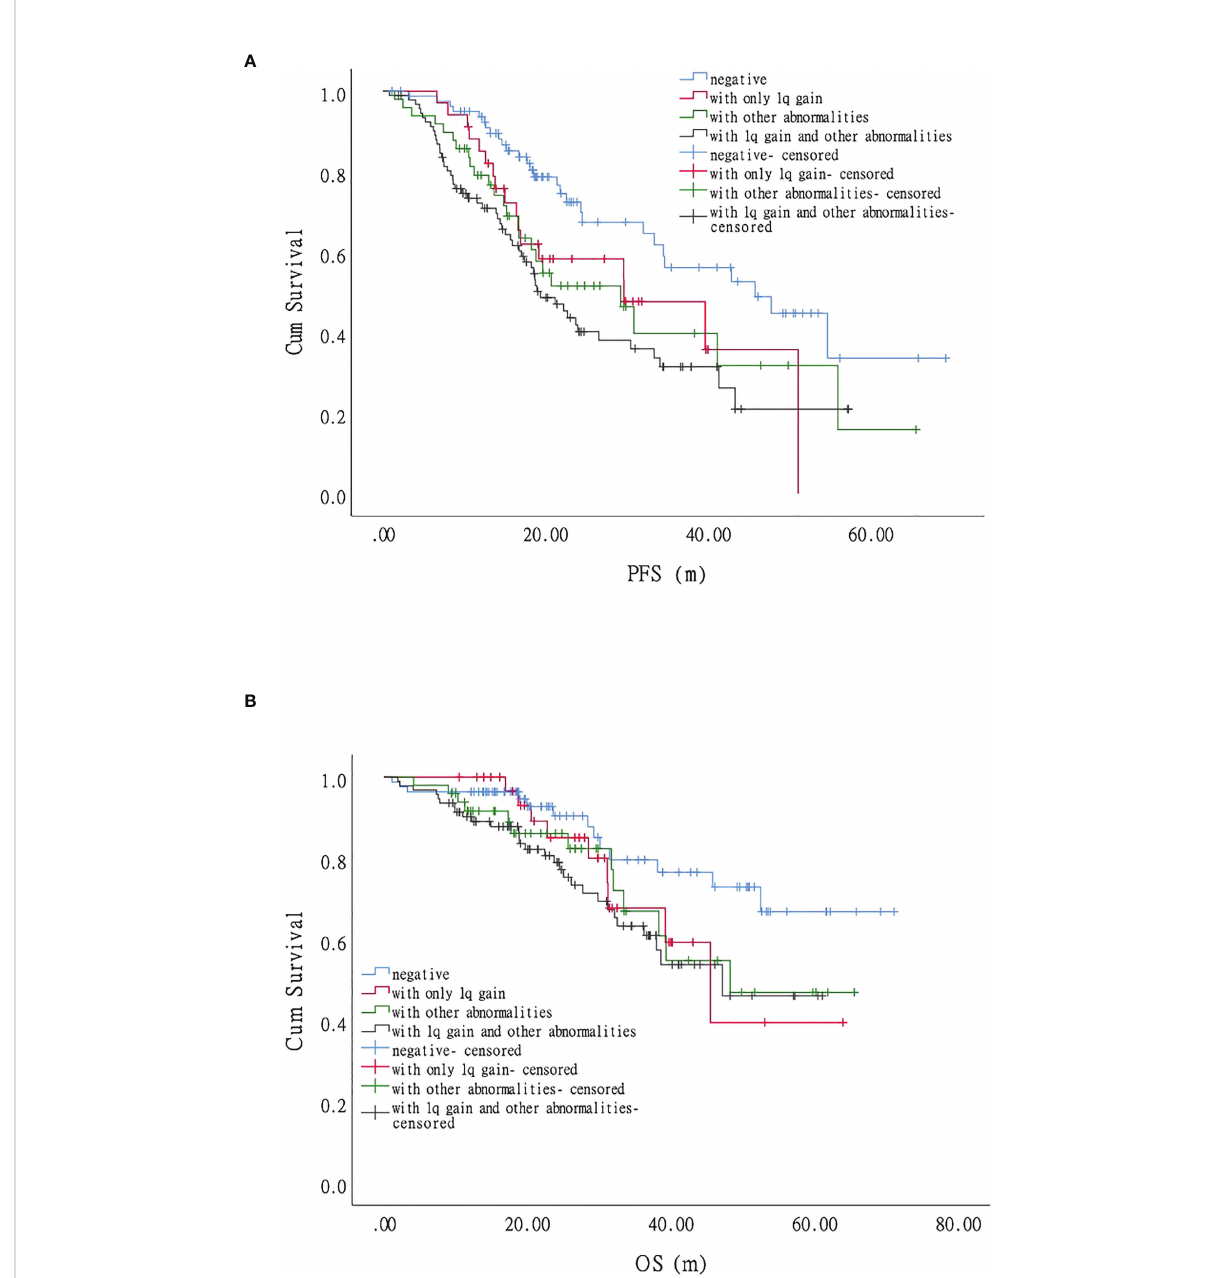
FIGURE 4 Impact of 1q gain and its accompanying chromosomal abnormalities on the survival of patients with myeloma. (A) . Progression-free survival (PFS) was signi fi cantly longer when comparing the FISH-negative group with the other abnormalities group and the +1q and other abnormalities group, respectively, but there was no signi fi cant difference with the +1q group. (B) . Compared with the fl uorescence in situ hybridization (FISH)- negative group, only the other abnormality group, showed a signi fi cant difference in overall survival